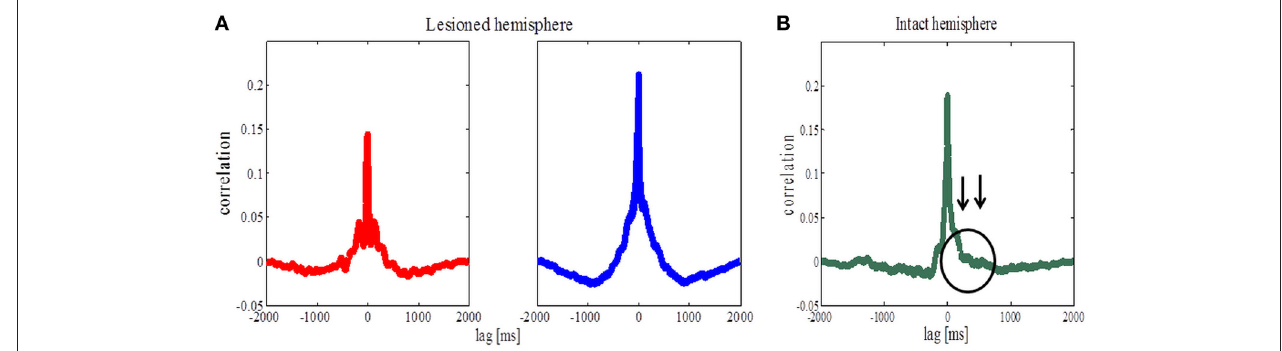
FIGURE 4 | Cross-correlation analysis of the lesioned and intact hemispheres. (A) Average correlation values before (the left panel) and after (the right panel) levodopa administration in the case of the lesioned hemisphere. (B) Average correlation values in the case of the intact hemisphere. Arrows are pointing to an asymmetric increase corresponding to striatal signals being shifted forward in time compared to the opposite scenario.